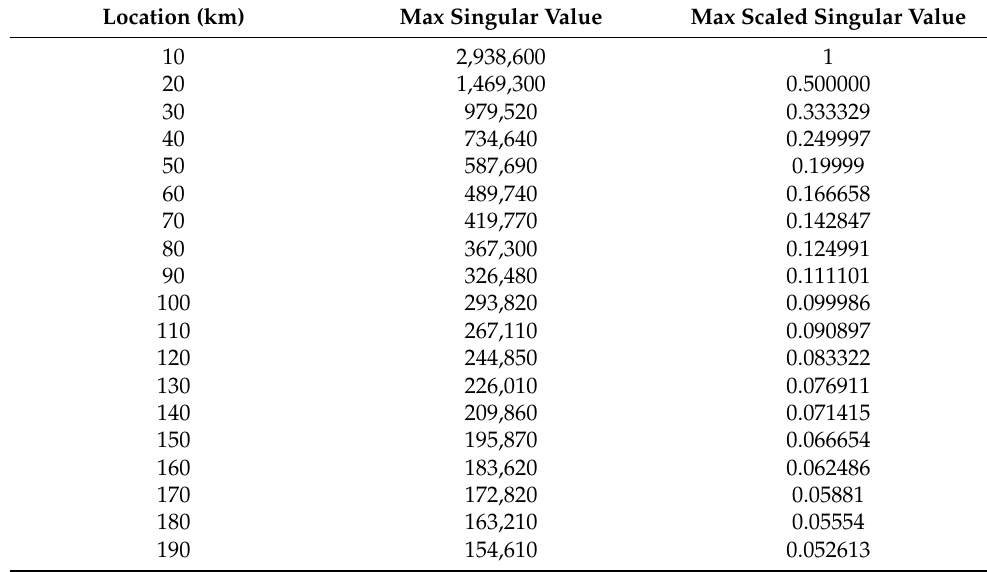
Table A11. The maximum singular and its scaled values for LLL fault at 19